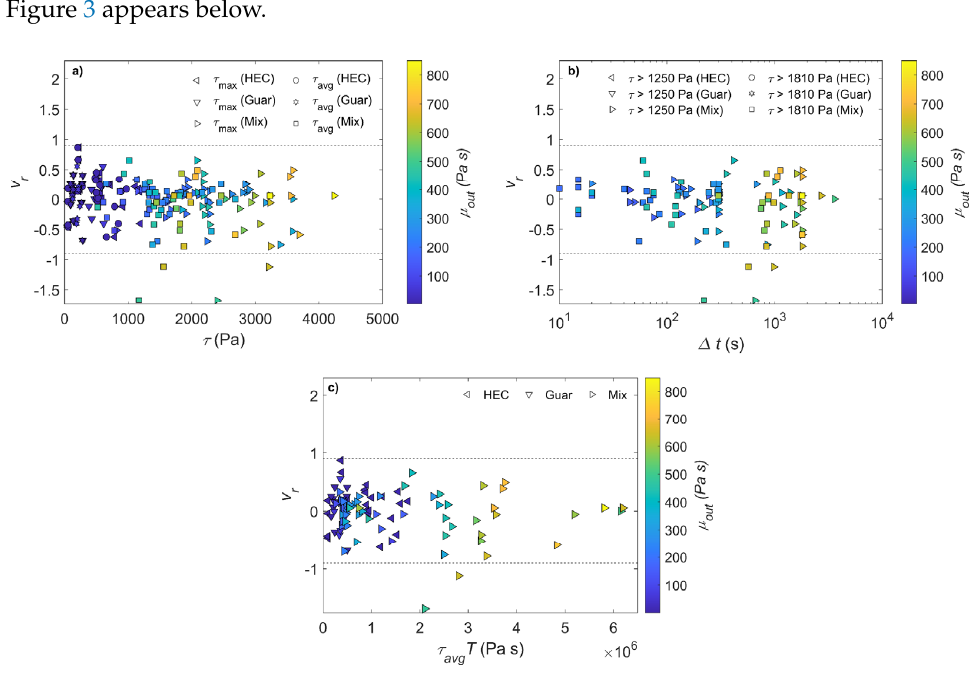
Figure 3. Bacterial removal efficiency as a function of ( a ) the maximum and time-averaged shear stress; ( b ) the time during which the shear stress exceeded the critical values reported in Lange et al. [27] for cell damage and lysis; ( c ) the product of average shear stress and treatment time. The horizontal dashed lines represent the 95% confidence interval for the removal efficiency calculated from the confidence intervals for the Colilert Quanti-Tray 2000 assay. The color bars report the viscosity of the